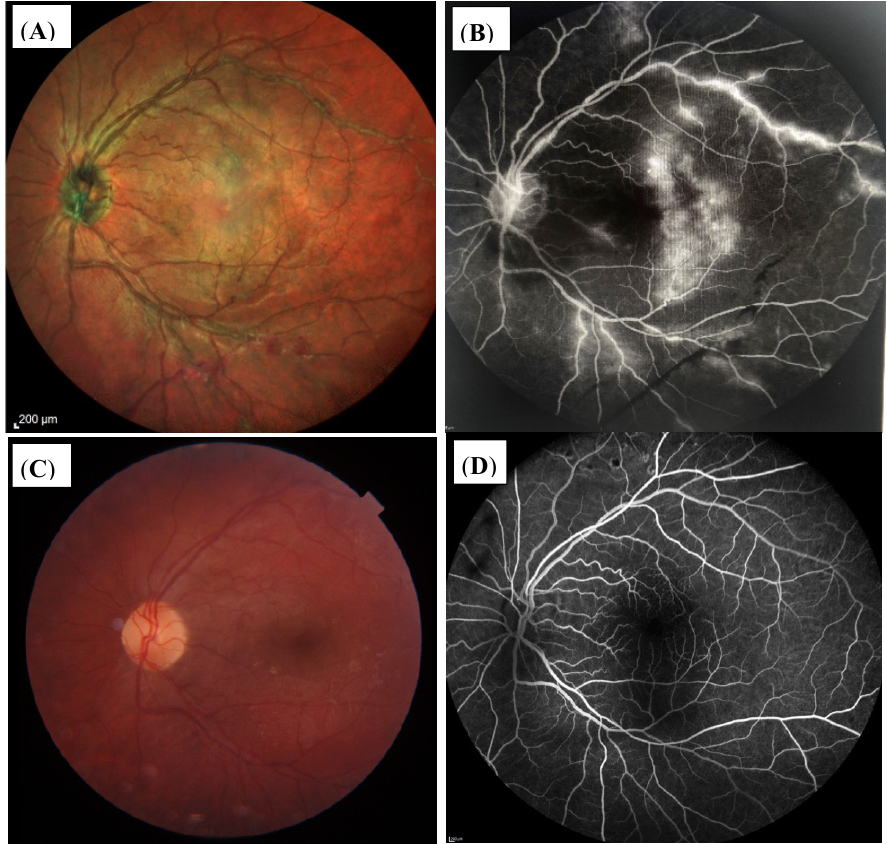
Figure 9. ( A – D ) Shows the retina of the left eye (OS) of patient 13 before and after therapy. ( A ) (fundus picture) and ( B ) (fluoresceine angiography (FAG) show occlusive retinal vasculitis. ( C ) (fundus picture) and ( D ) (FAG) display the OS after treatment, showing a normal fundus appearance and FAG. The BCVA was 0.0 logMar.